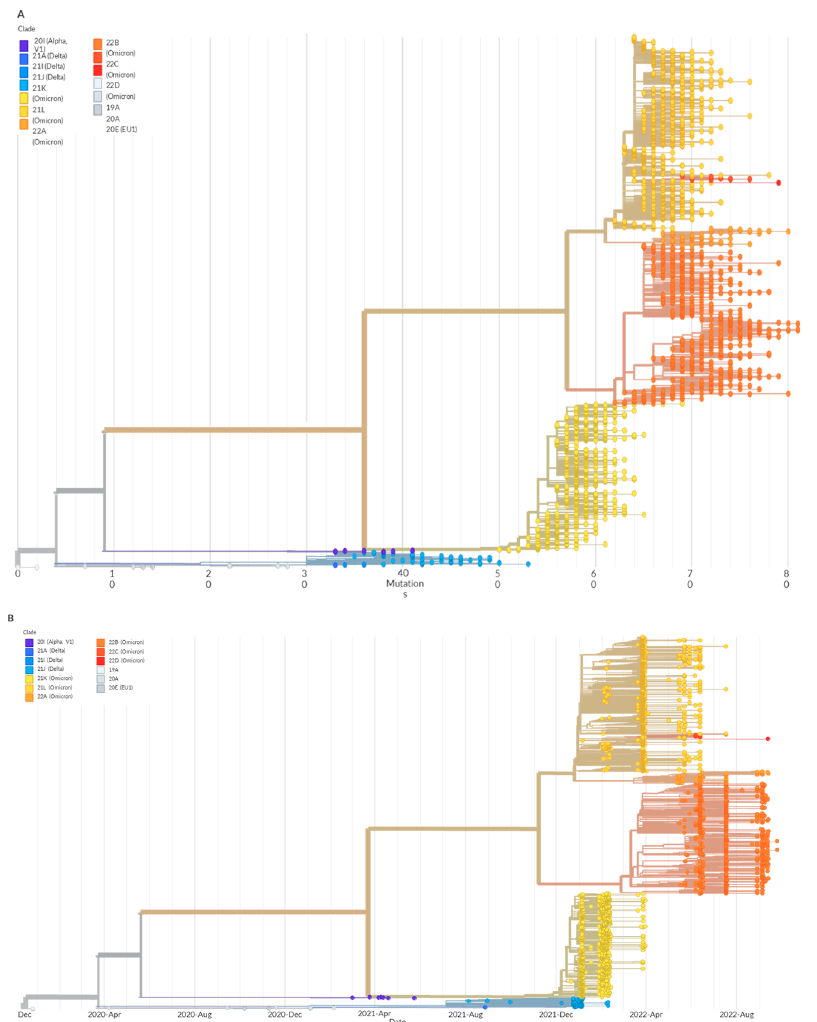
Figure 1. Phylogenetic distribution of SARS-CoV-2 genomes. ( A ) Phylogenetic trees generated by Nextstrain [29]. Of 3384 genomes, 2519 are highlighted. Clade 22 B is the dominant clade. This phylogenetic analysis shows different variants present in all sequences and their mutational profiles.